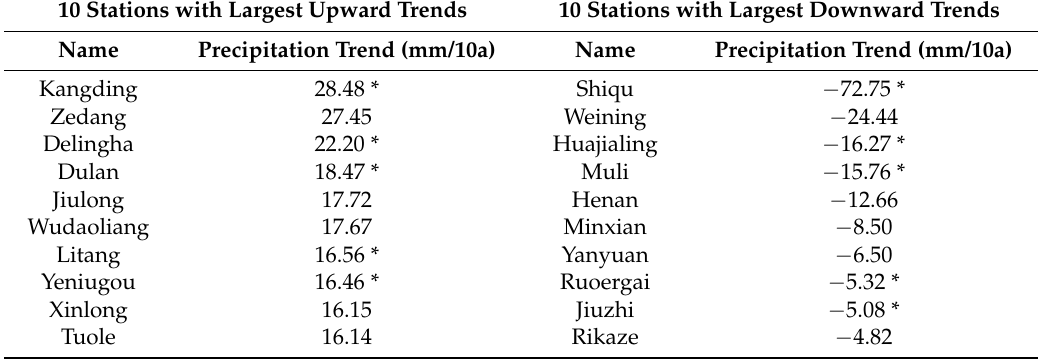
Table 4. Information of the ten stations with the largest upward (downward) trends in precipitation during 1961–2015.